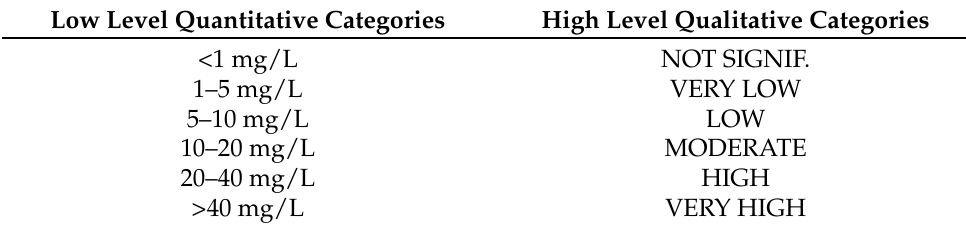
Table 2. Chl-a classes and association between low and high level categories.